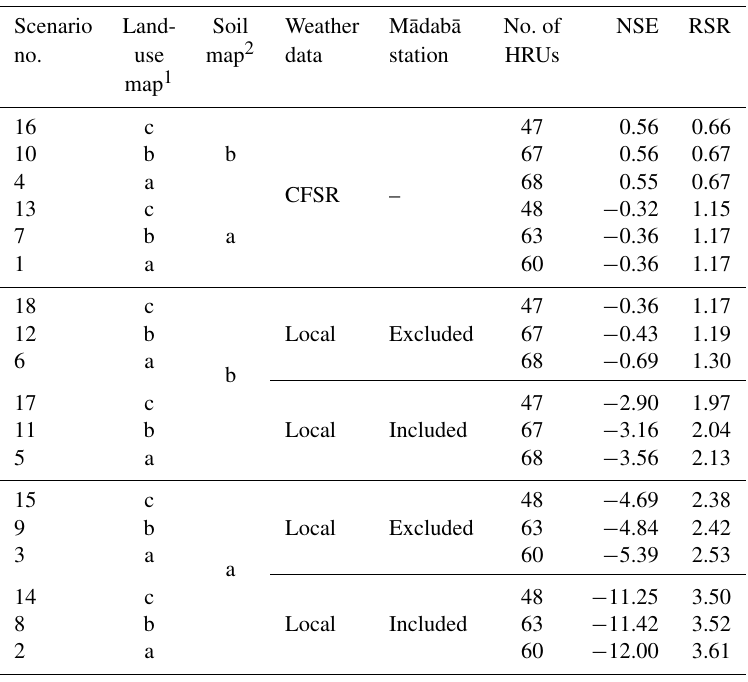
Table 1. Number of HRUs and values of NSE and RSR calculated for 18 scenarios for comparison of observed and simulated average monthly discharge (m 3 s − 1 ) at the Wala catchment outlet.